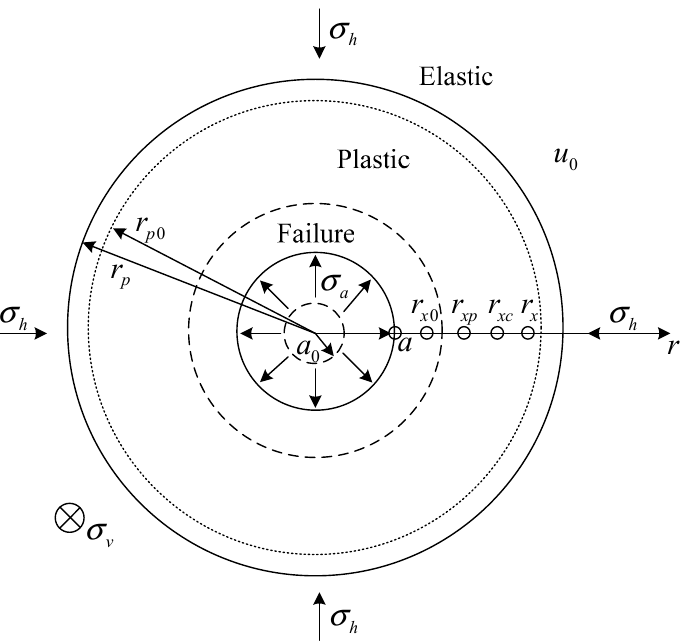
Figure 3. Mechanical model for undrained cylindrical cavity expansion in the SCC soil.